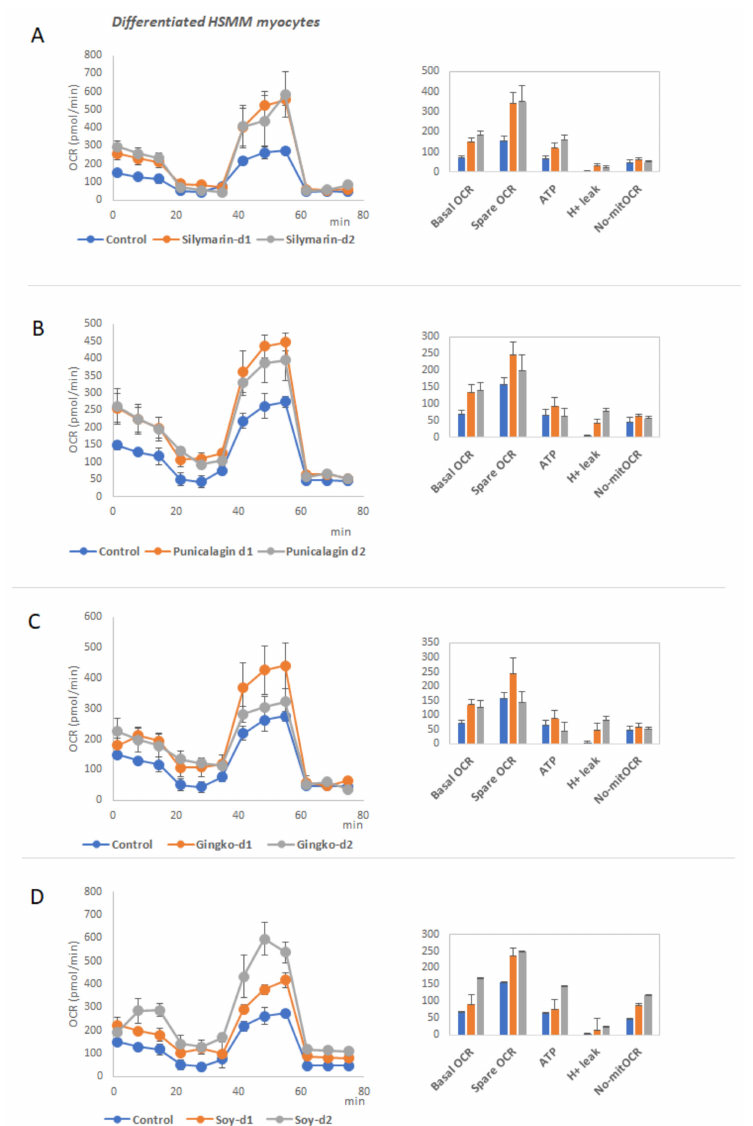
Figure 7. Effect of the extracts on mitochondrial oxidative phosphorylation of differentiated hu- man myocytes. ( A – D ) MitoStress profile of the OCR after the sequential addition of modulators of the electron transport chain of differentiated myocytes treated with different extracts (Figure 7A treated with Silymarin extract, Figure 7B Punicalagin, Figure 7C Ginkgo, and Figure 7D Soy, respec- tively). Quantification of basal OCR, Spare respiratory capacity, ATP production linked to oxidative phosphorylation, H + leak and non-mitochondrial